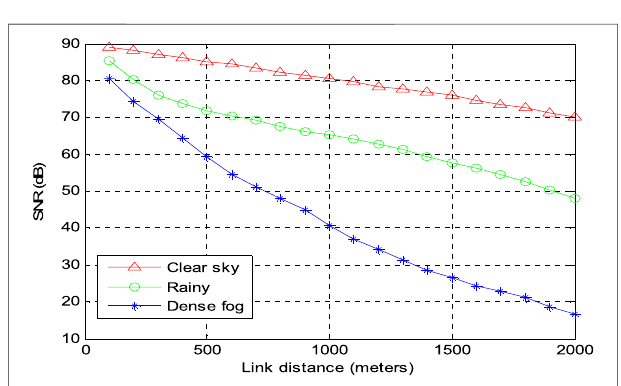
FIGURE 12 | Relationship between SNR and link distance for different meteorological conditions while using EDFA.